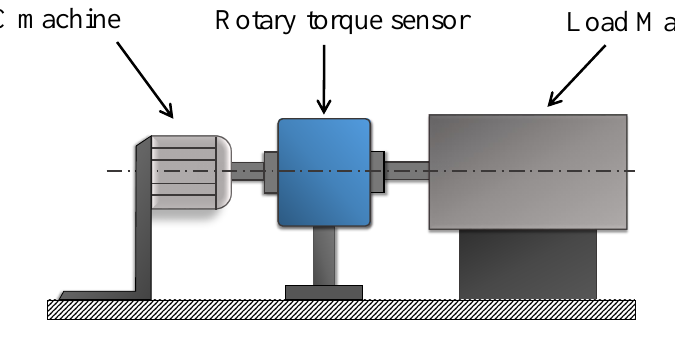
Figure 8. Schematic of the setup for direct measurements of the shaft torque Q sh of DC generators.